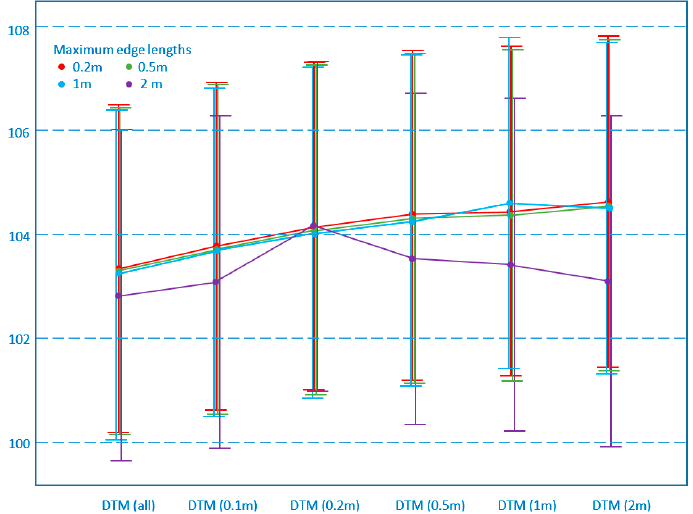
ff ect DTM Resolution - Multipatch maximum edge Figure 6. Profile Plot for interaction effect DTM Resolution - Multipatch maximum edge length. Figure 6. Profile Plot for interaction e